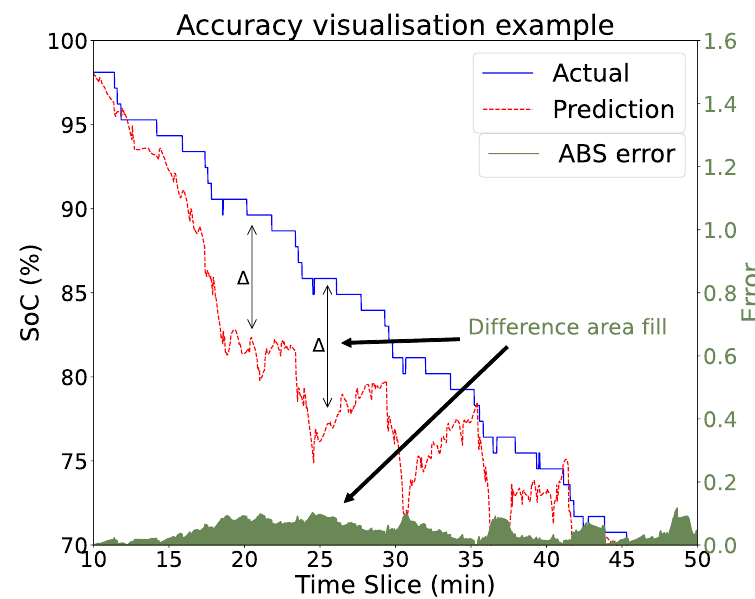
Figure 9. Accuracy plot